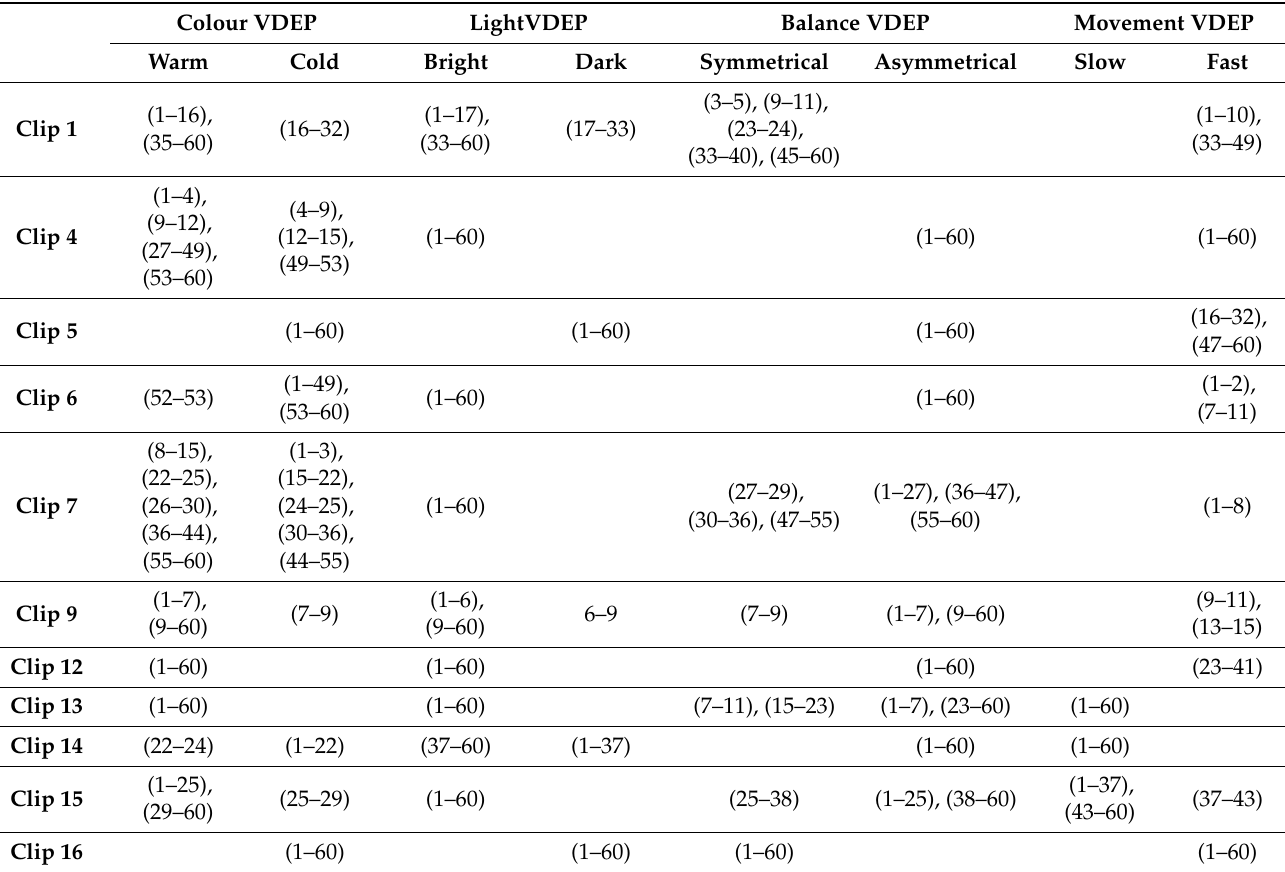
Table A11. VDEPs tagging of the selected video samples from the DEAP